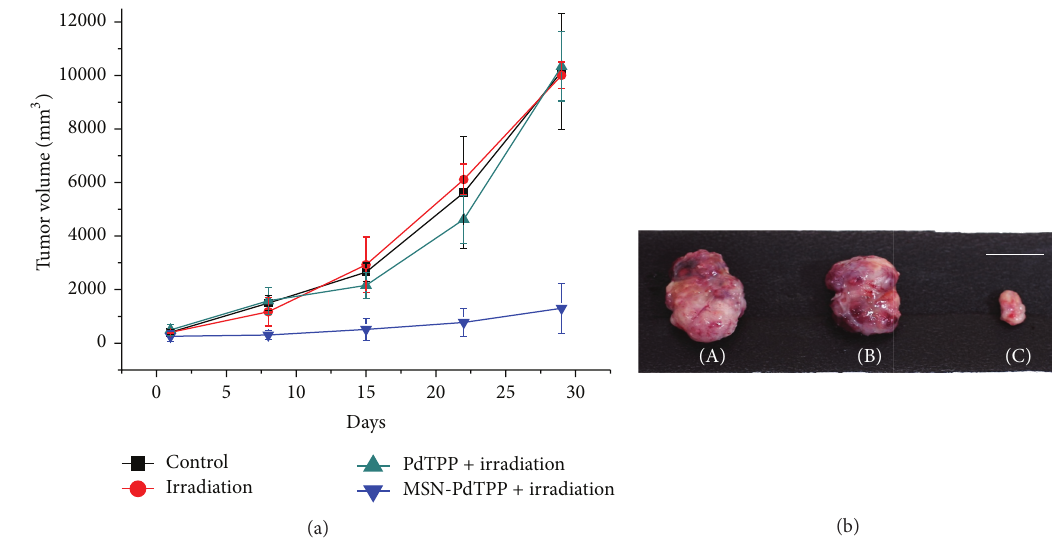
Figure 5: (a) 29-day comparative PDT efficacy studies of MDA-MB-231 s.c. xenograft nude mouse model subjected to a single intratumoral injectionof(i)salinewithoutphotoirradiation(blacksquares),(ii)salinewithphotoirradiation(redcircles),(iii)PdTPPwithphotoirradiation (green upward-pointing triangles), and (iv) MSN-PdTPP with photoirradiation (blue downward-pointing triangles)—showing MSN-PdTPP to be highly efficacious in tumor reduction. Datapoints denote mean of twelve mice per group. (b) Photographs of tumors harvested